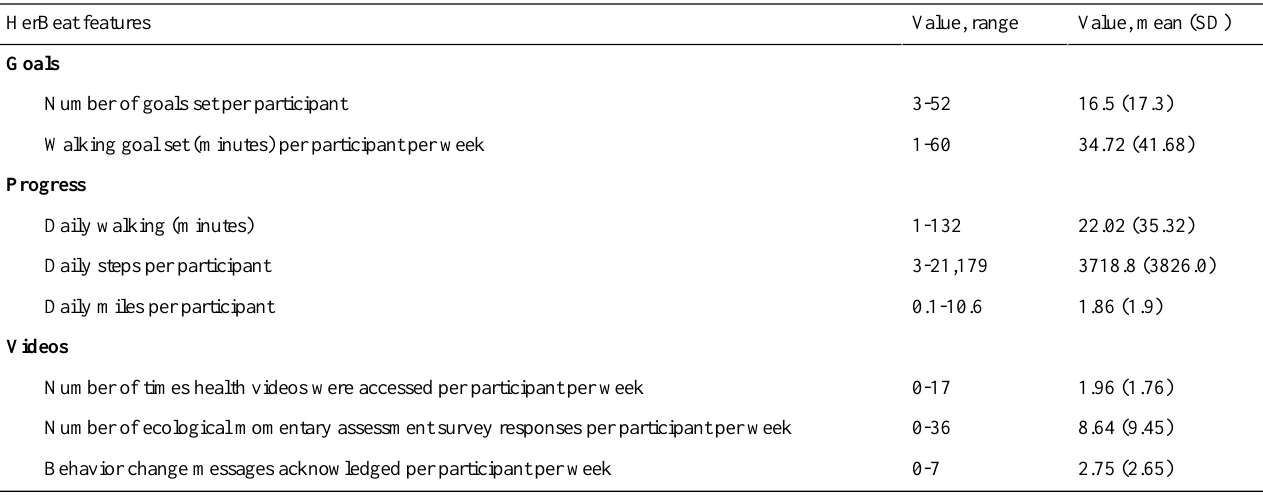
Table 4. Participants’engagement